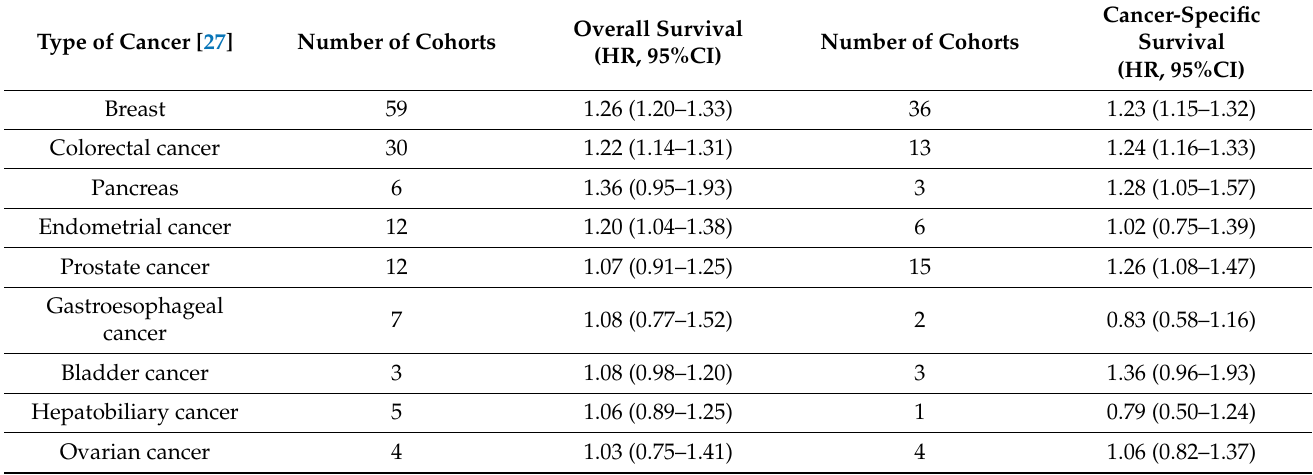
Table 3. Relationship between obesity and overall survival and cancer-specific survival in some major solid-organ